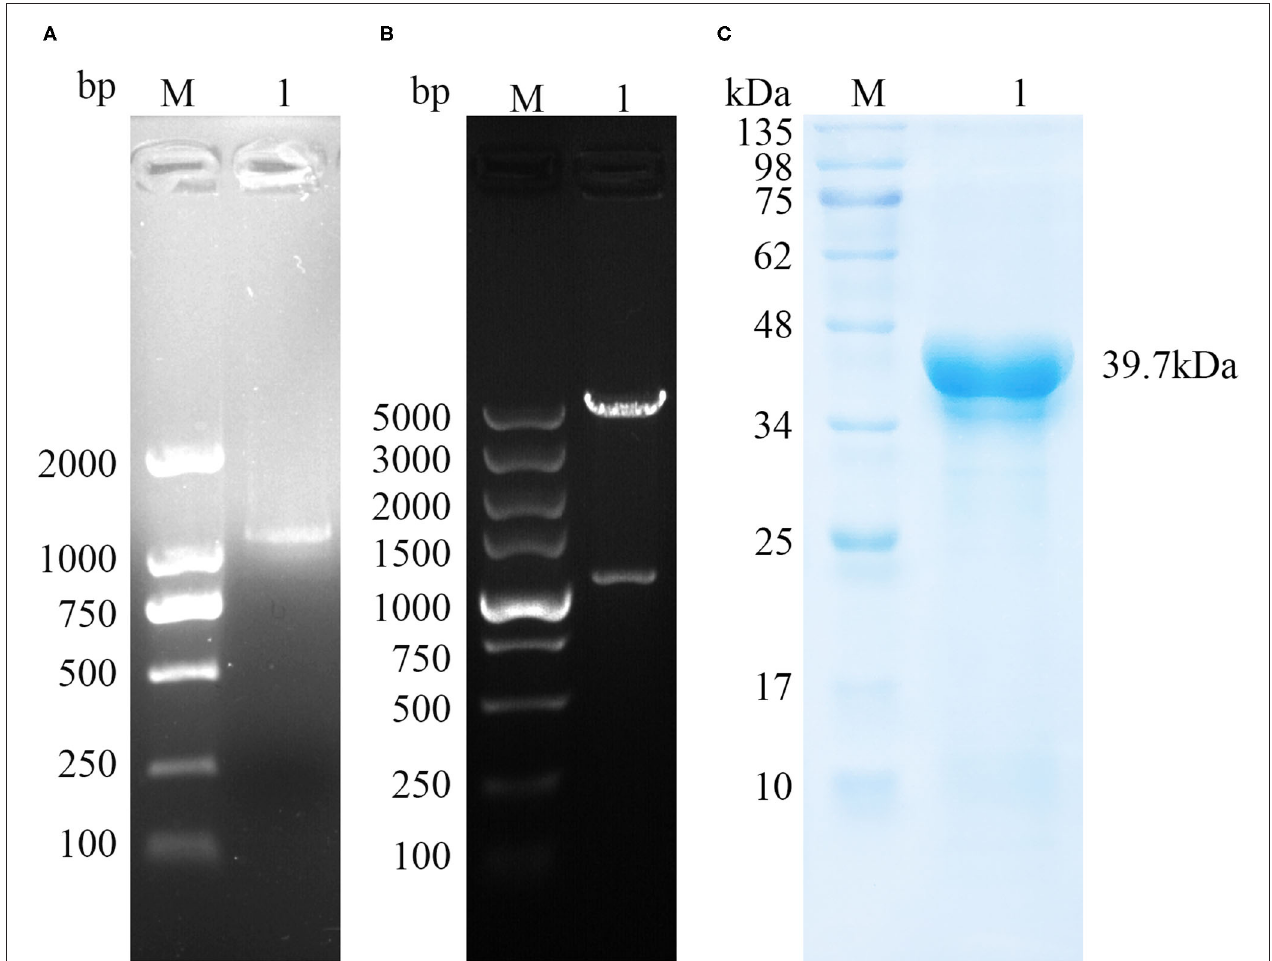
FIGURE 1 | Gene cloning and protein purification of TgPLP2. (A) The amplification of TgPLP2 determined by agarose gel electrophoresis. (B) Double-enzyme digestion of pET30a-TgPLP2. (C) Purified rTgPLP2 was analyzed by SDS-PAGE gel and visualized by Coomassie blue